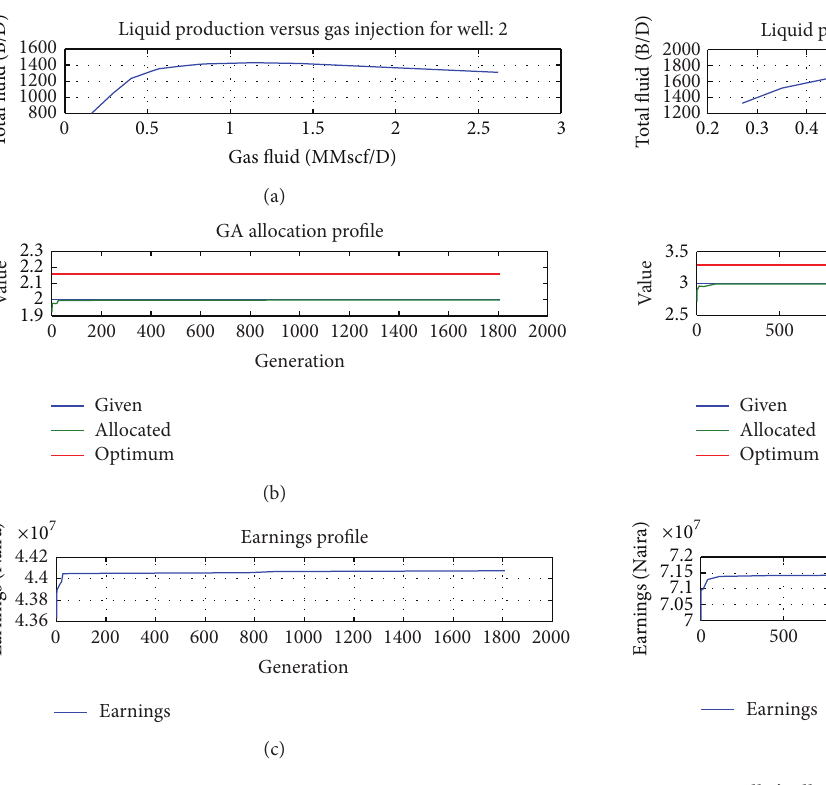
Figure 8: Well 2’s allocation profile, wells 1-2 GA allocation profile, and wells 1-2 earnings (Naira) for a limited scenario.